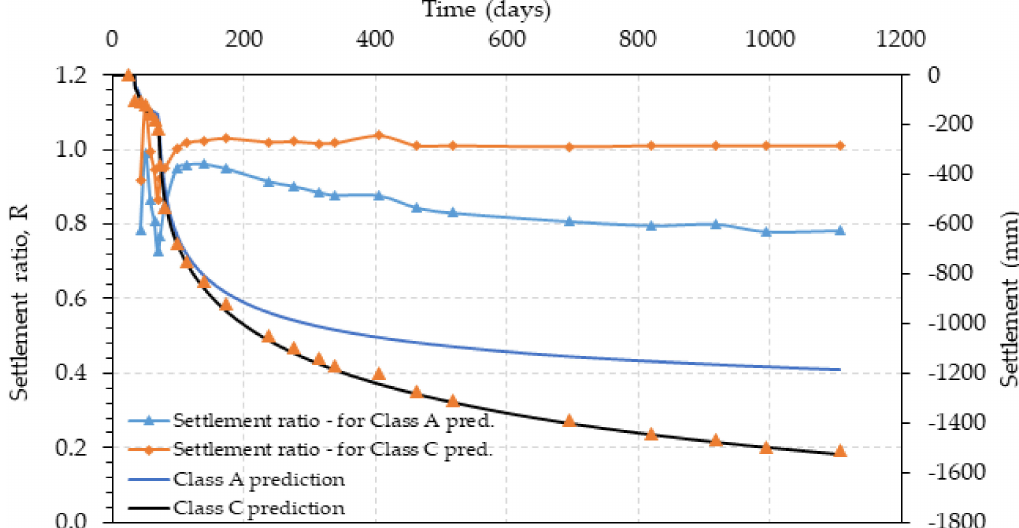
Figure 6. Settlement ratio and predicted settlements vs. time for Ballina